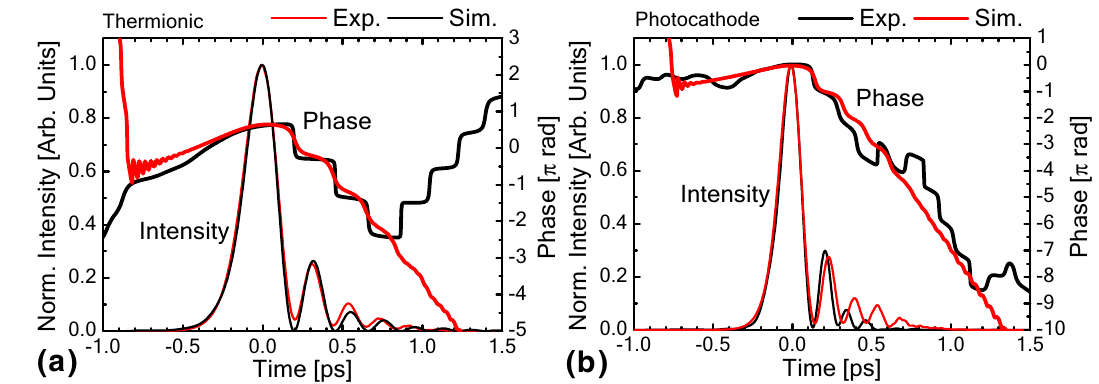
Figure 3. Comparison with 1D numerical simulation results. ( a ) Thermionic operation. ( b ) Photocathode operation.